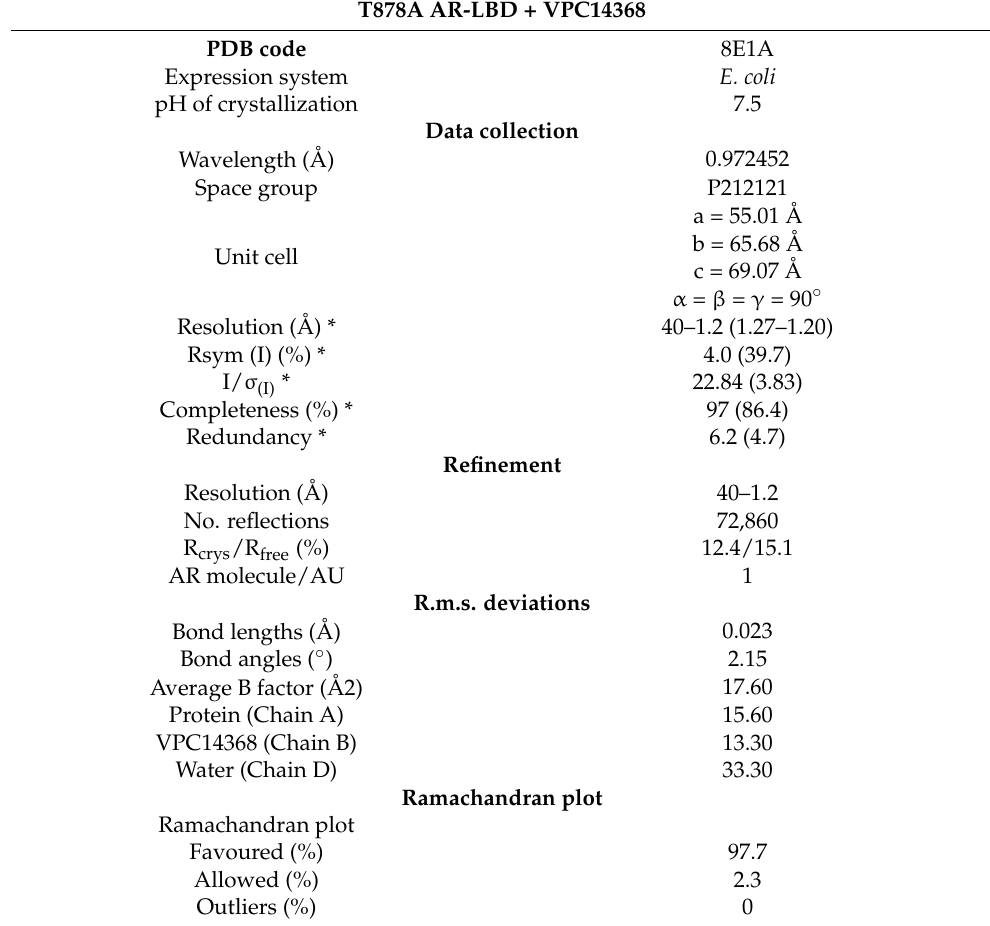
Table 2. Data collection and refinement statistics.